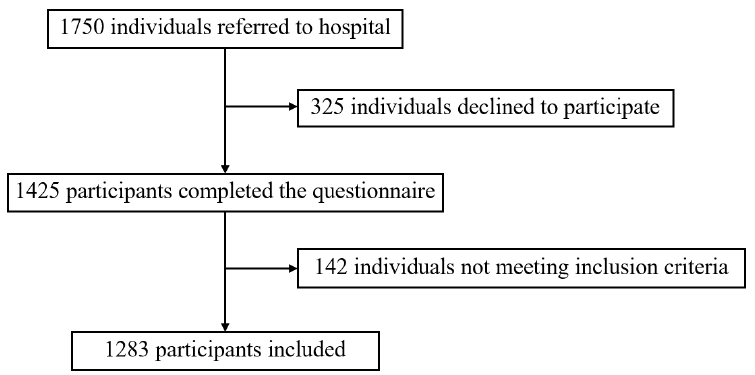
Figure 1. Participants ’ recruitment flow